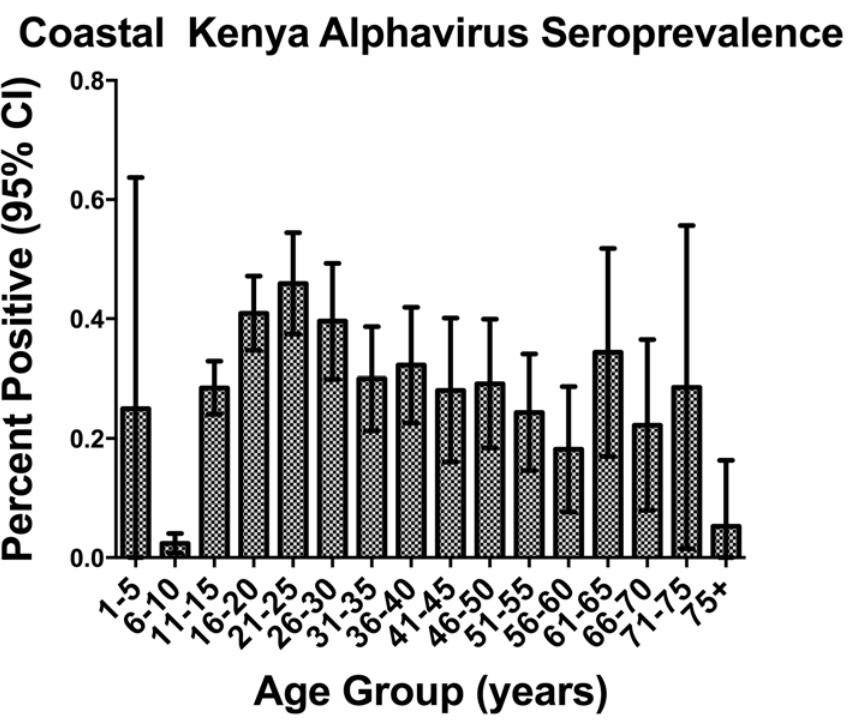
Figure 2. Alphavirus seroprevalence as measured by ELISA displayed by age. 95% CI indicated by bars. for both villages and shows regions within both villages with seropositive households. The G (cid:3) local statistic indicates a significant hot spot clusters (red circles) of high alphaviral seropreva- lence houses in Nganja (scale was 200m)(Fig. 5). Blue circles in Milalani indicate significant rel- ative clustering of negative households (cold spots) in the adjacent area to the southwest. The G (cid:3) local statistic indicates a few significant hot spot clusters of high density houses in the south central end of Vuga (scale of 200m)(Fig. 5).